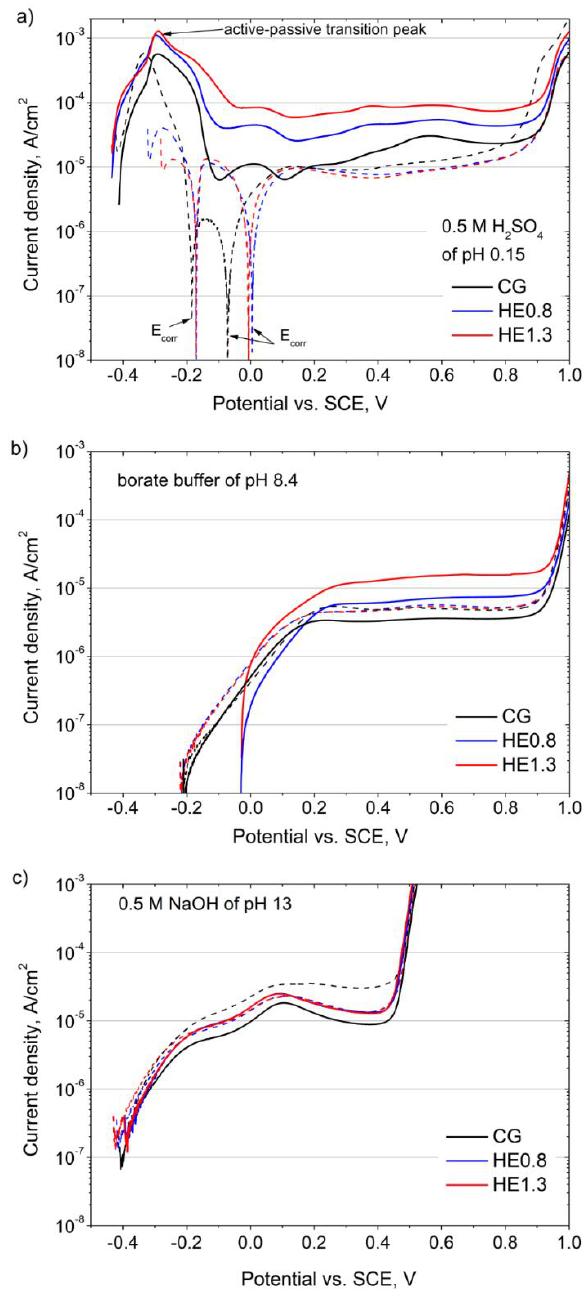
Figure 4. Anodic potentiodynamic polarization curves of the CG, HE0.8, and HE1.3 samples rec- orded in ( a ) 0.5 M H 2 SO 4 , ( b ) borate buffer (0.1 M H 3 BO 3 + 0.024 M Na 2 B 4 O 7 ) and ( c ) 0.5 M NaOH on cross-section (solid lines) and longitudinal section (dash